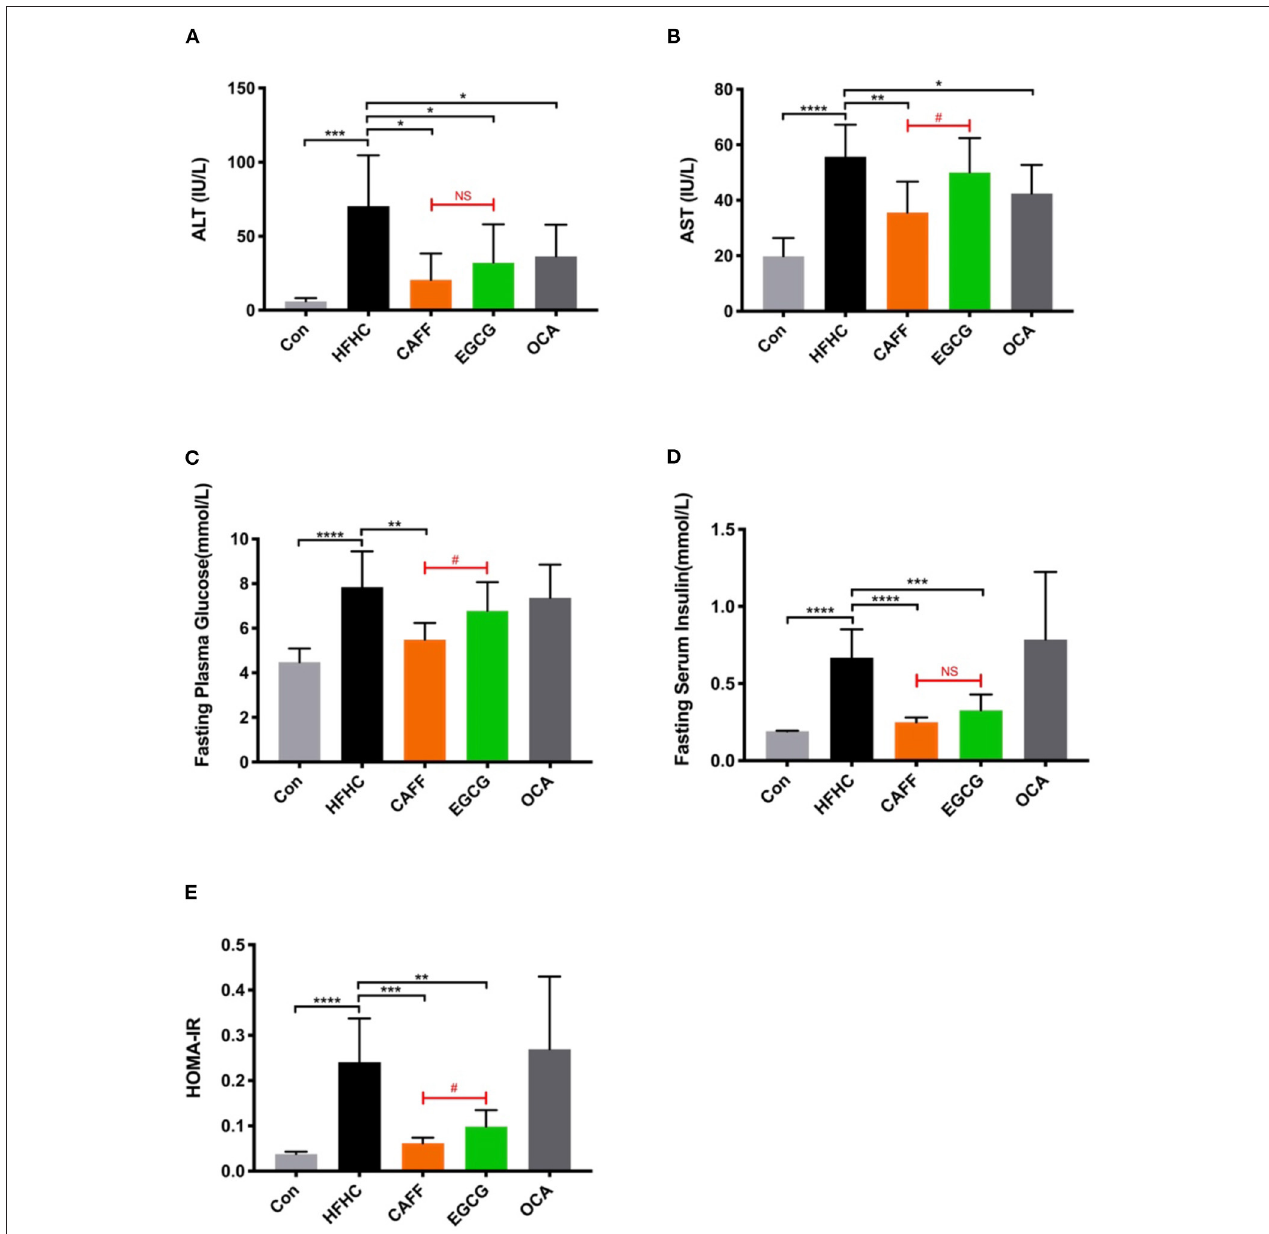
FIGURE 3 | Caffeine and EGCG reverse biochemical parameters in NASH mice. Changes in serum ALT (A) and AST (B) activities, FBG (C) , FINS (D), and HOMA-IR (E) of the mice from each group ( n = 8) vs. HFHC, * P < 0.05, ** P < 0.01, *** P < 0.001, **** P < 0.0001; vs. EGCG, # P < 0.05, NS, not significant.